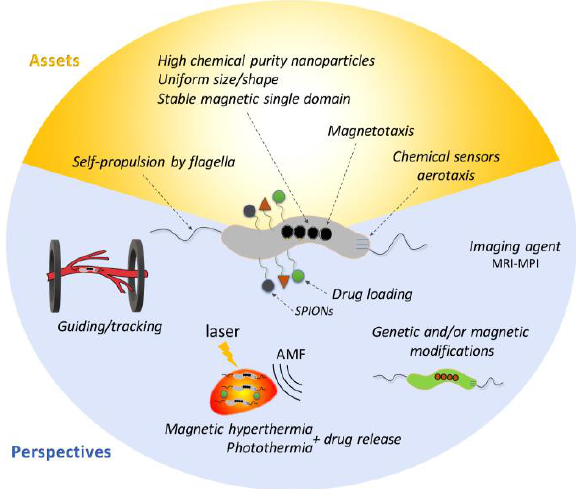
Figure 6. Schematic representation of the biological features of MTB, which determines the prospects for their use as theranostics agents in oncology. At present, only the fundamental properties of